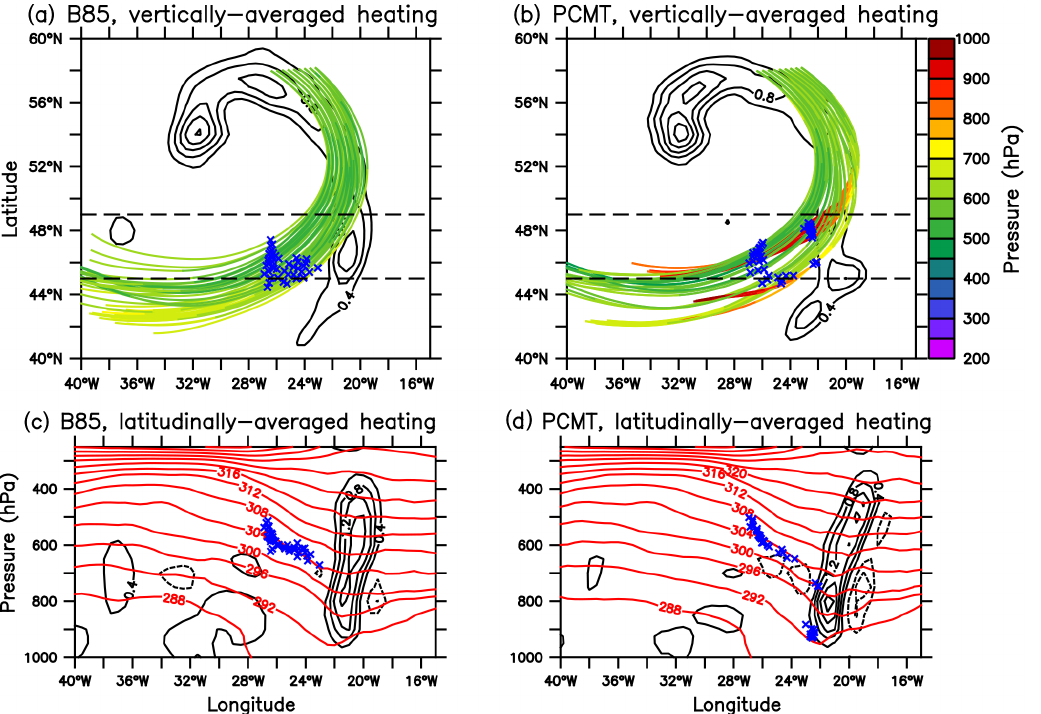
Figure 7. Pressure (shading) along trajectories reaching the positive PV difference in leg 2 for (a) B85 and (b) PCMT, vertically averaged heating between 300 and 900hPa (black contours; units: 0.4Kh − 1 ) and trajectories position (blue crosses) at 03:00UTC, 2 October. Vertical cross-sections of heating averaged between 45 ◦ and 49 ◦ N (black contours; second method of computation), potential temperature (red contours) and trajectory positions (blue crosses) at 03:00UTC 2 October for (c) B85 and (d)